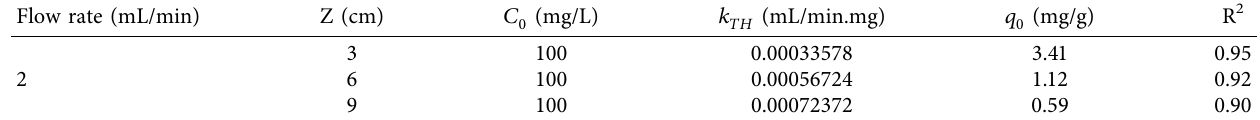
Table 9: Thomas model parameters for cadmium